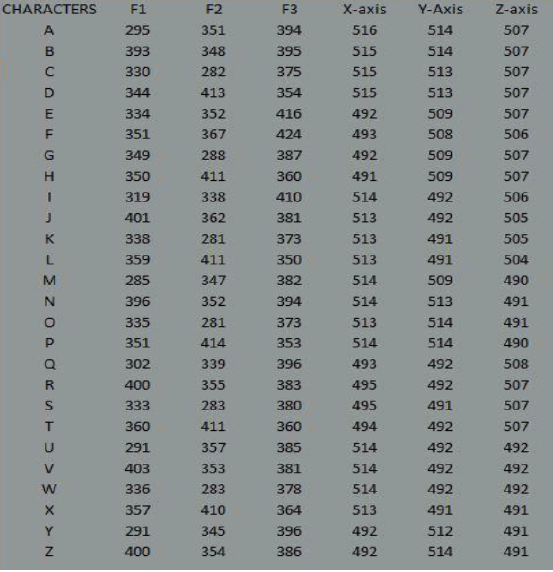
Figure 4: Voltage levels for idle state of the glove.